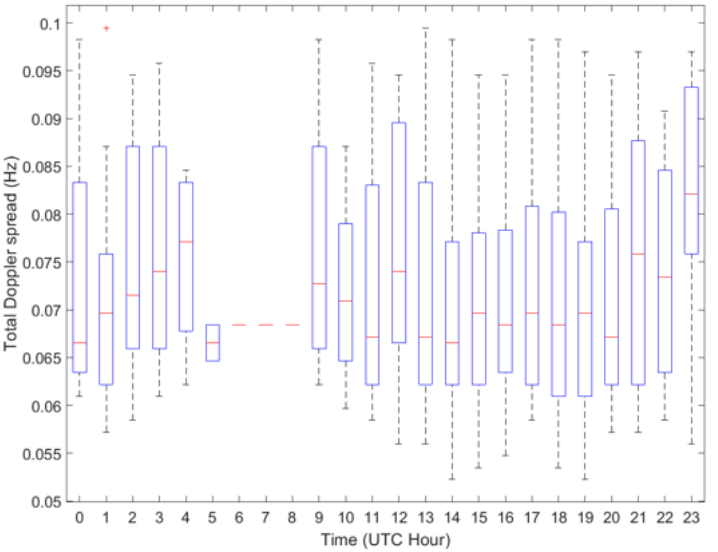
Figure 11. NVIS Total Doppler Spread vs. Time.